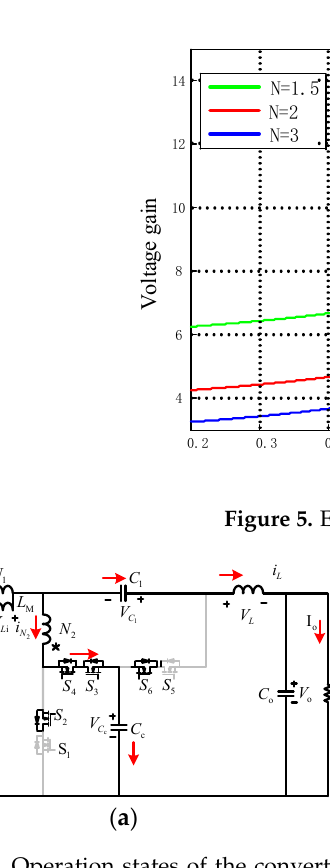
Figure 6. Operation states of the converter when in V > 0: ( a ) Non-shoot through state; ( b ) Shoot through state.